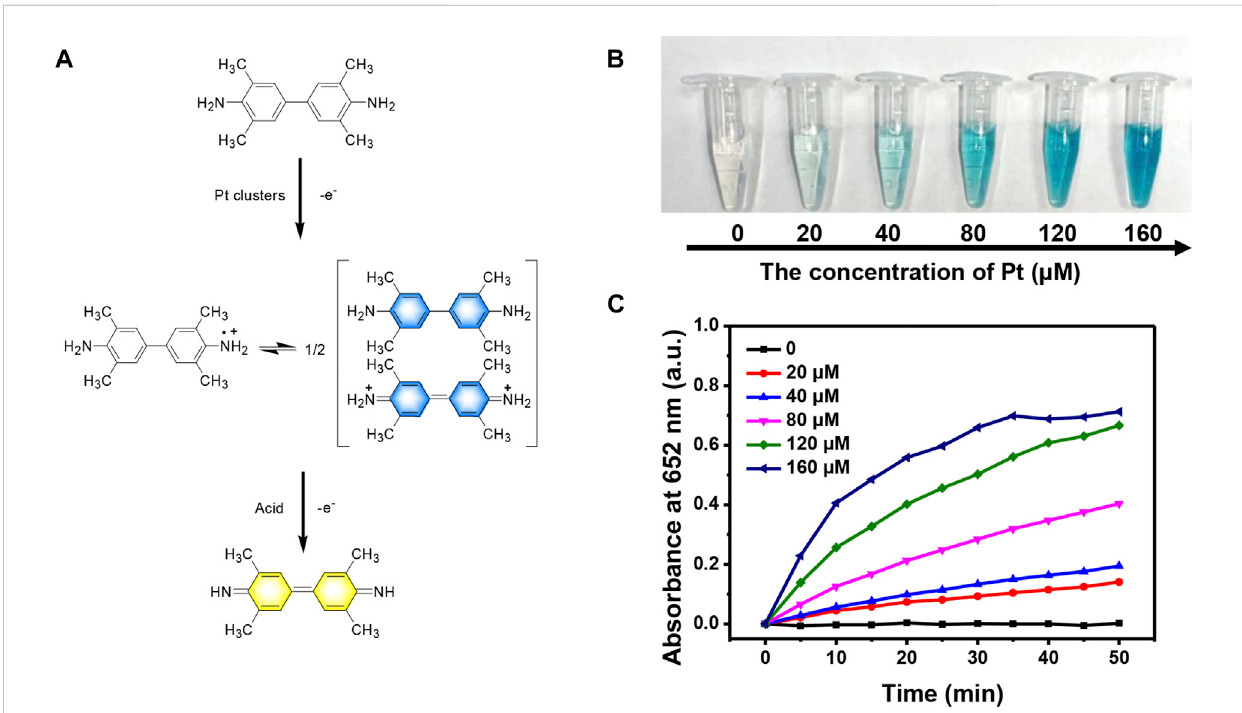
Peroxidase-like activity of Pt clusters. (A) Chemical reaction formula of TMB catalytic under Pt clusters; (B) Color changes of TMB at 5 min in the mixture containing 800 μ M TMB and 100 μ M H 2 O 2 in the presence of Pt clusters with serial concentration. (C) Time-dependent absorbance change